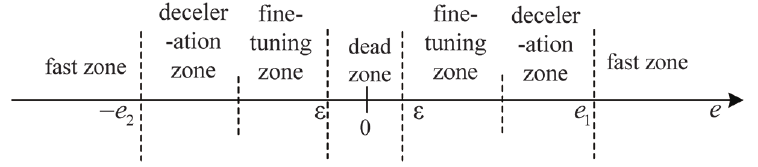
Figure 14. Optimal control strategy of pneumatic control valve.